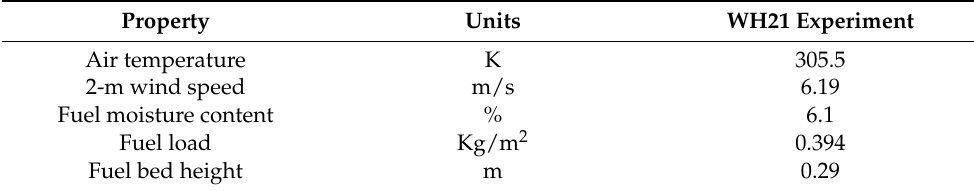
Table 1. Weather characteristics, fuel structure, and fuel moisture content (Cruz et al.,